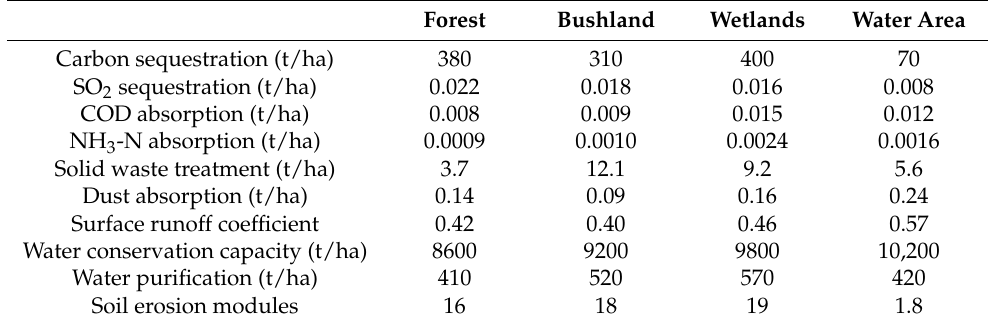
Table 1. Modeling inputs for ecosystem. Forest Bushland Wetlands Water Area